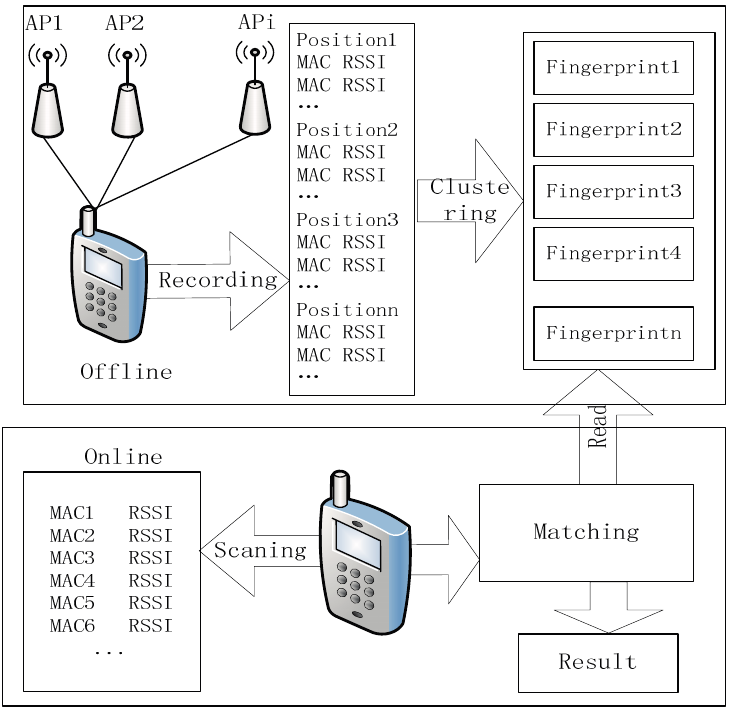
Figure 1. Positioning